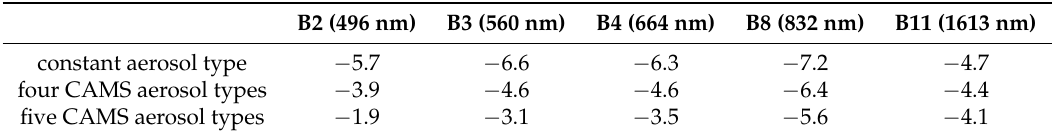
Table 8. Relative bias [%] of surface reflectances between the MACCS-ATCOR Joint Algorithm (MAJA) and La Crau. CAMS: Copernicus Atmosphere Monitoring Service.